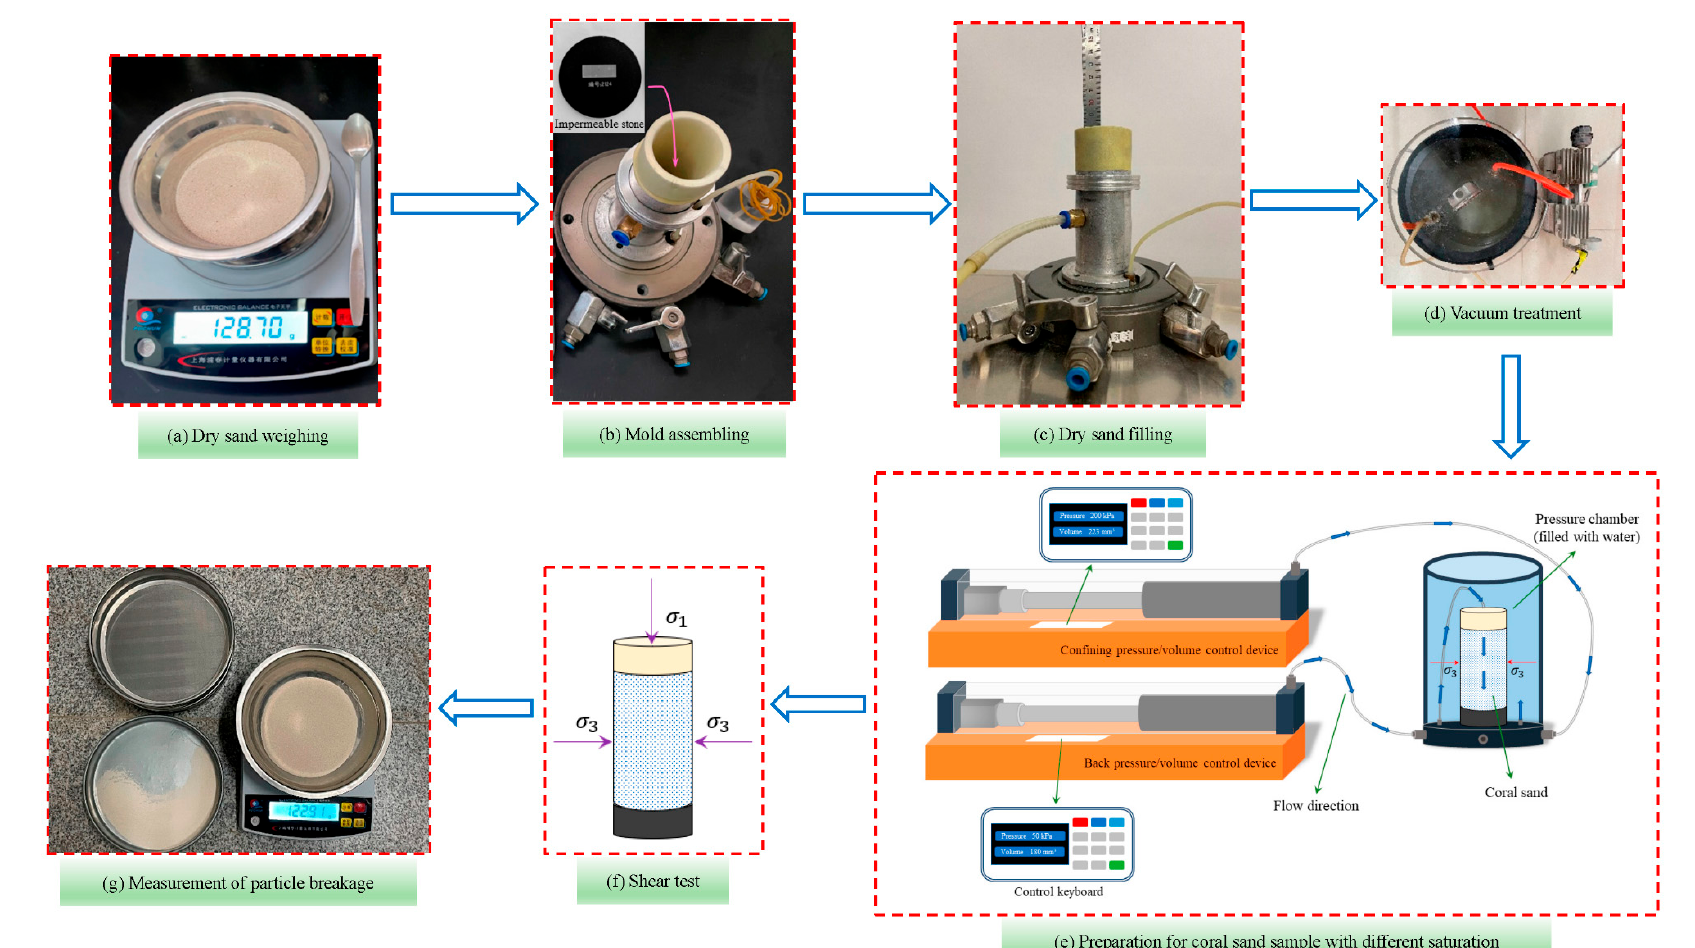
Figure 3. Diagrammatic sketch of test procedures.